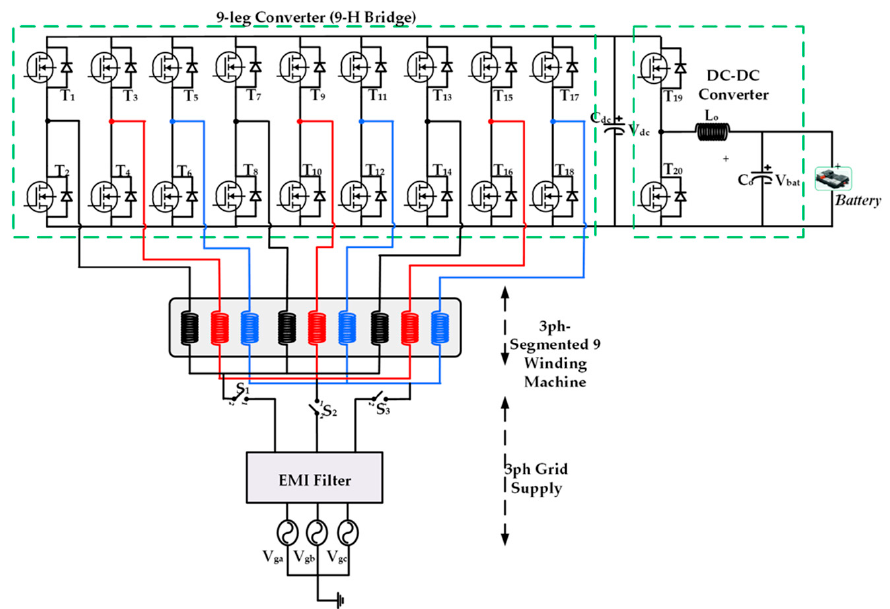
Figure 15. Integrated On − Board Charger based on 3-Phase 9-Segmented Winding Machine pro- posed by Raherimihaja et al. [83] in 2018 (iOBC11).